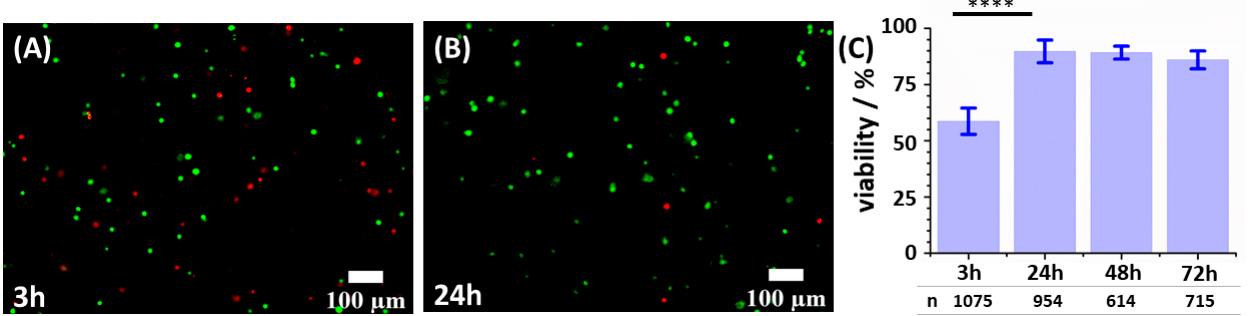
Figure 2. Live/dead assay with calcein-AM/propidium iodide. ( A , B ) Living cells (green, calcein-AM) and dead cells (red, propidium iodide) in a 3D bioprinted cervical tumor model at 3 h ( A ) and 24 h ( B ) after printing. ( C ) Viability of 3D bioprinted HeLa cells at 3 h, 24 h, 48 h, and 72 h after printing. Population size, n , i.e., the number of cells evaluated for each time point, is reported for each bar of the graph. Levels of statistical significance are calculated as detailed in Section 2.9 and are indicated as follow: ****, p < 0.0001.